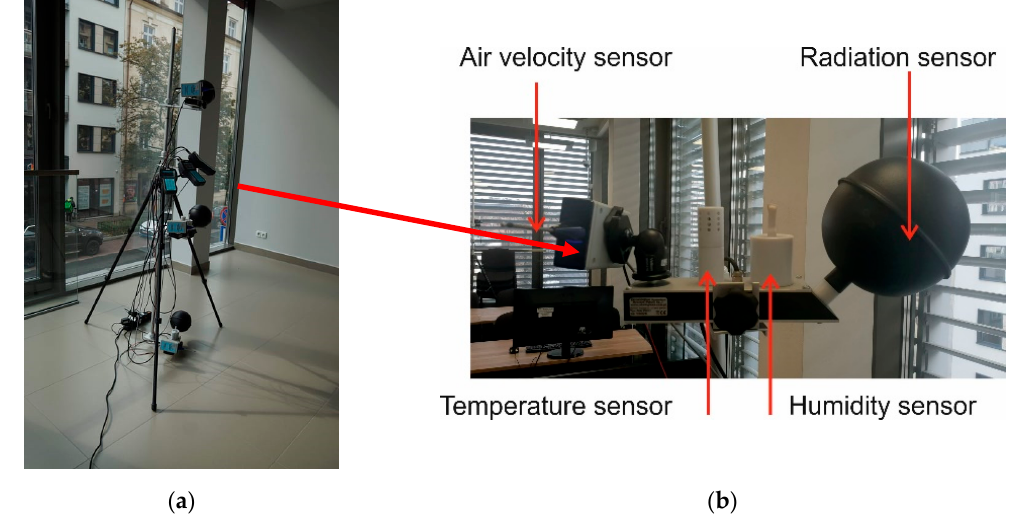
Figure 3. ( a ) View of microclimate meter. ( b ) Description of sensors. Table 2. Sensors’ specifications.